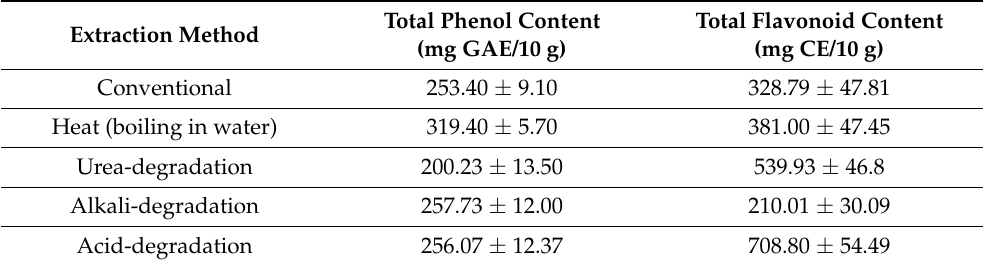
Table 4. Total phenol and flavonoid content of silk sericin from B. mori extracted through different methods. Adapted from